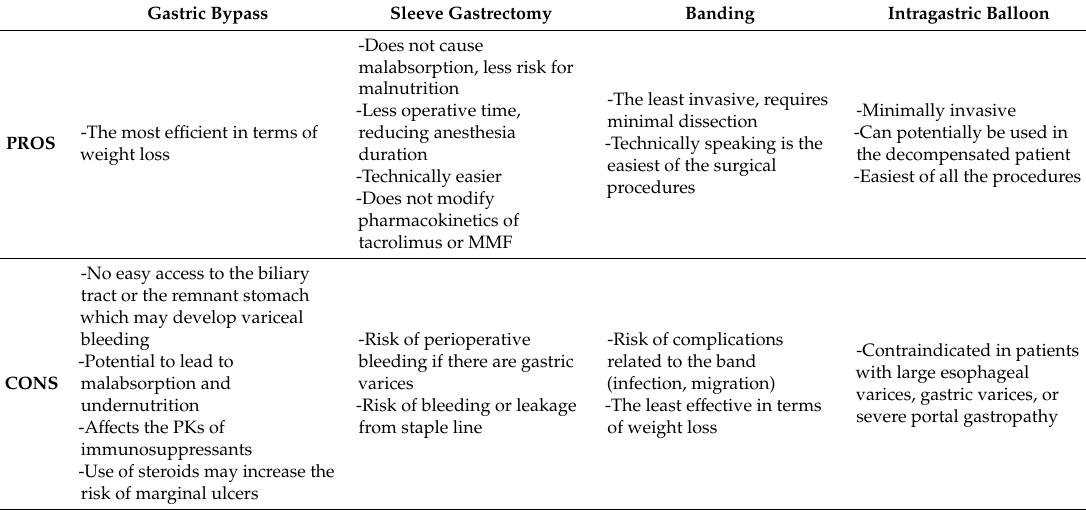
Table 2. Pros, cons, and weight loss of di ff erent bariatric approaches in the liver transplant setting. Gastric Bypass Sleeve Gastrectomy Banding Intragastric